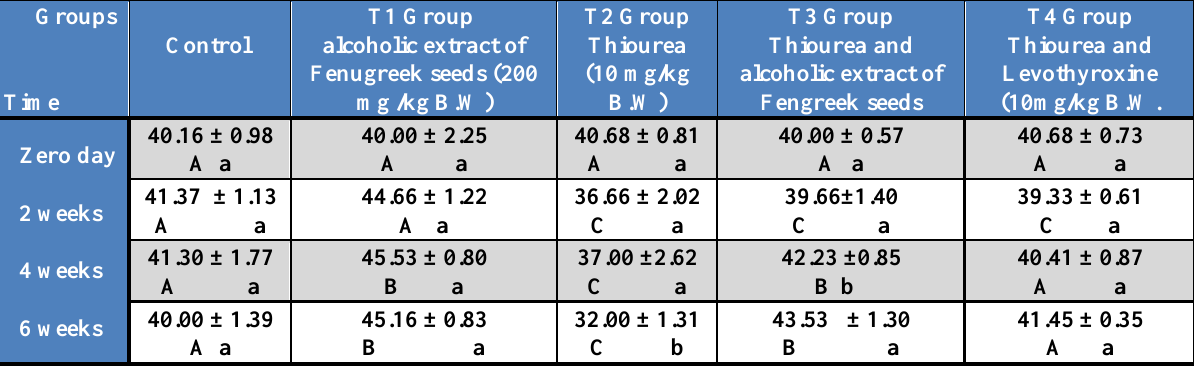
Table, 2: Effect of alcoholic extract of fenugreek seeds, thiourea and levothyroxine on PCV% in adult male rabbits